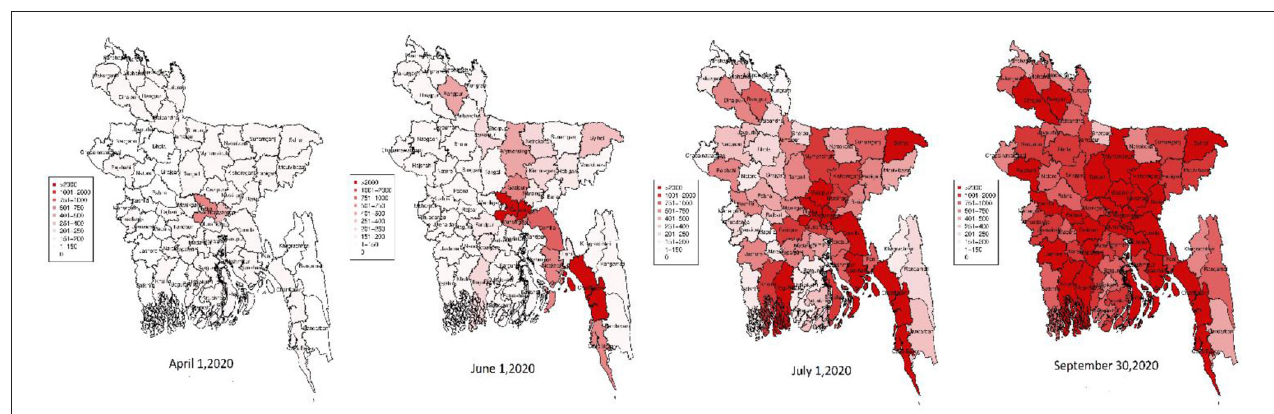
FIGURE 9 | Spread of COVID-19 positive cases in